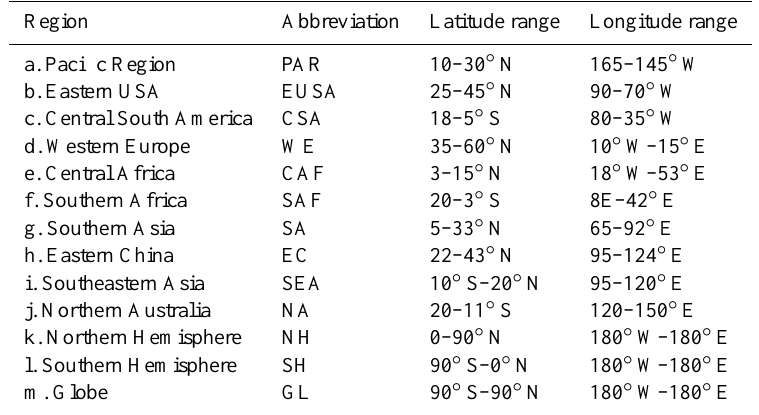
Table 1. Geolocation and abbreviation of the regions considered in the evaluation of the spatial distribution and estimation of the regional and global trend of EMAC-simulated surface